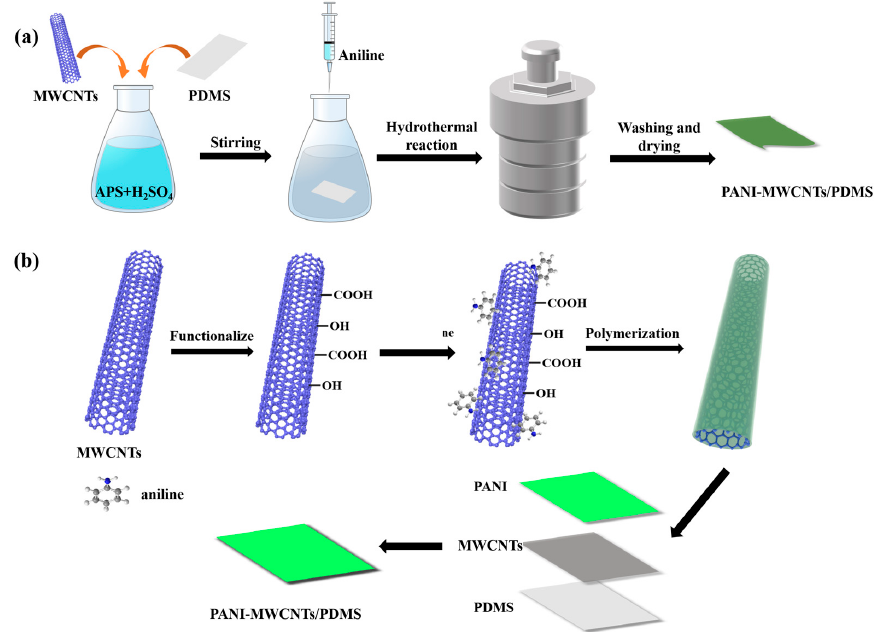
Figure 1. Schematic diagram of the preparation ( a ) and microstructure ( b ) of PANI-MWCNTs/PDMS films.